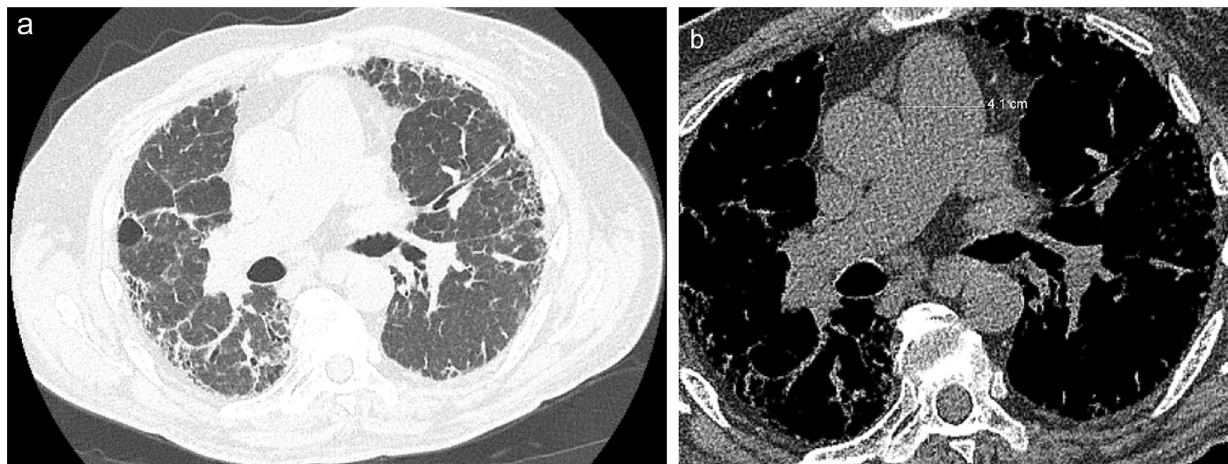
Fig. 5 Pulmonary hypertension in a patient with idiopathic pulmonary fibrosis. a Axial CT image (lung window) shows basal and peripheral predominant fibrotic disease with reticulation and honeycombing extending to the subpleural surface, as well as traction bronchiectasis,